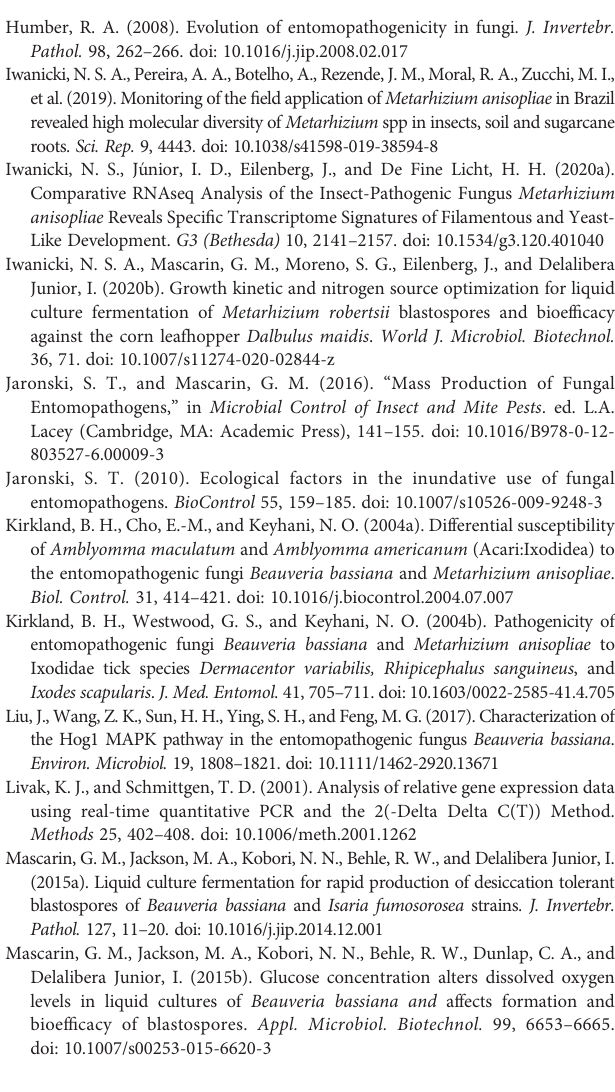
Supplementary Table 1 | Primer sequences used for qRT-PCR gene expression analyses. Supplementary Table 2 | Enriched Gene Ontology (GO), terms in Beauveria bassiana blastospores (between 20% and 10% within each culture day, and between culture days within each glucose concentration) resulted from Gene set enrichment